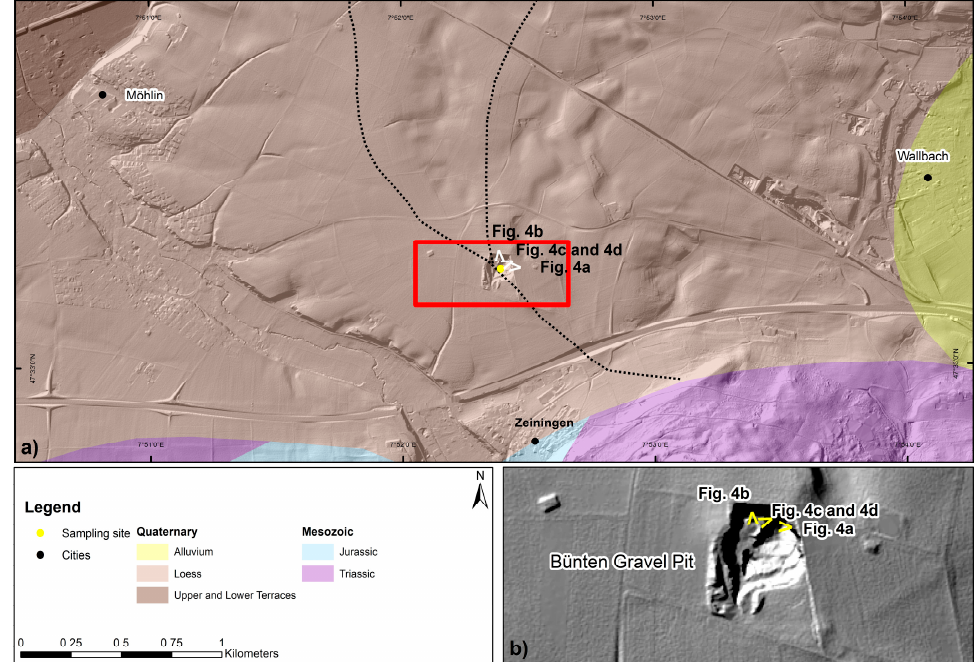
Figure 2. ( a ) Simplified geological map of the area around the Bünten gravel pit. For its extent, please refer to Figure 1. The yellow dot indicates the sampling site. The white angles in ( a ) and the yellow ones in ( b ) display the locations where the pictures in Figure 4 were captured. ( b ) DEM (Digital Elevation Model) of the Bünten gravel pit. The background map and the geological 1:500,000 map are reproduced with the authorization of the Swiss Federal Office of Topography (swisstopo).